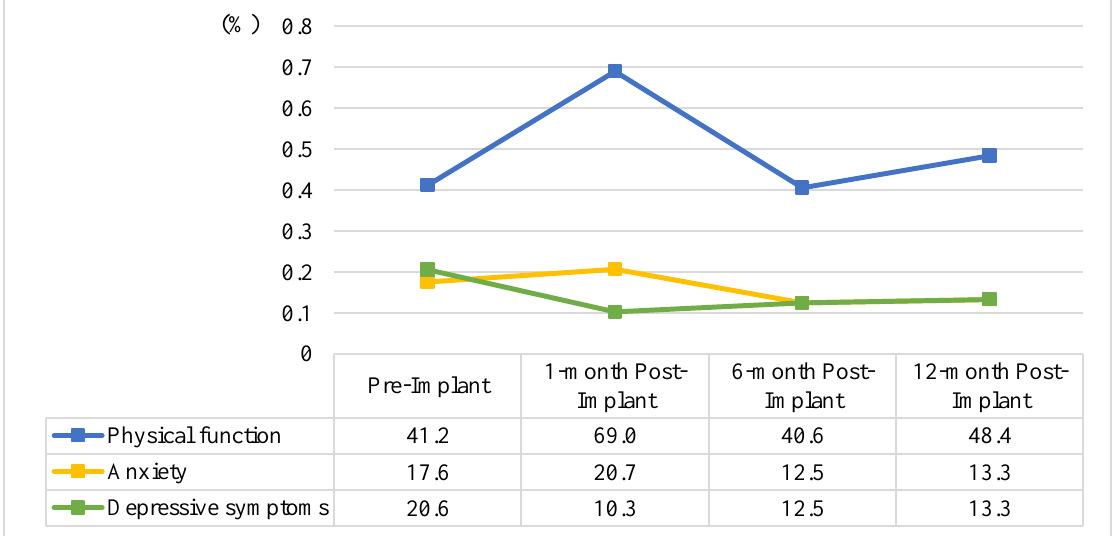
Figure 1. The prevalence of physical functional limitation, anxiety, and depressive symptoms in patients with implantable cardioverter-defibrillators. ICD, implantable cardioverter-defibrillator. Note: Use the Korean Activity Status Index scores < 46 for physical functional limitation and the Hospital Anxiety and Depression Scale scores ≥ 8 for clinically significant anxiety and depressive symptoms as cut-points. Table 3. Mixed Modeling Procedures: Time E ff ects on Pre-Implant-to 1, 6, and 12 months Post-Implant Changes in Physical Function and Psychological Distress of Defibrillator